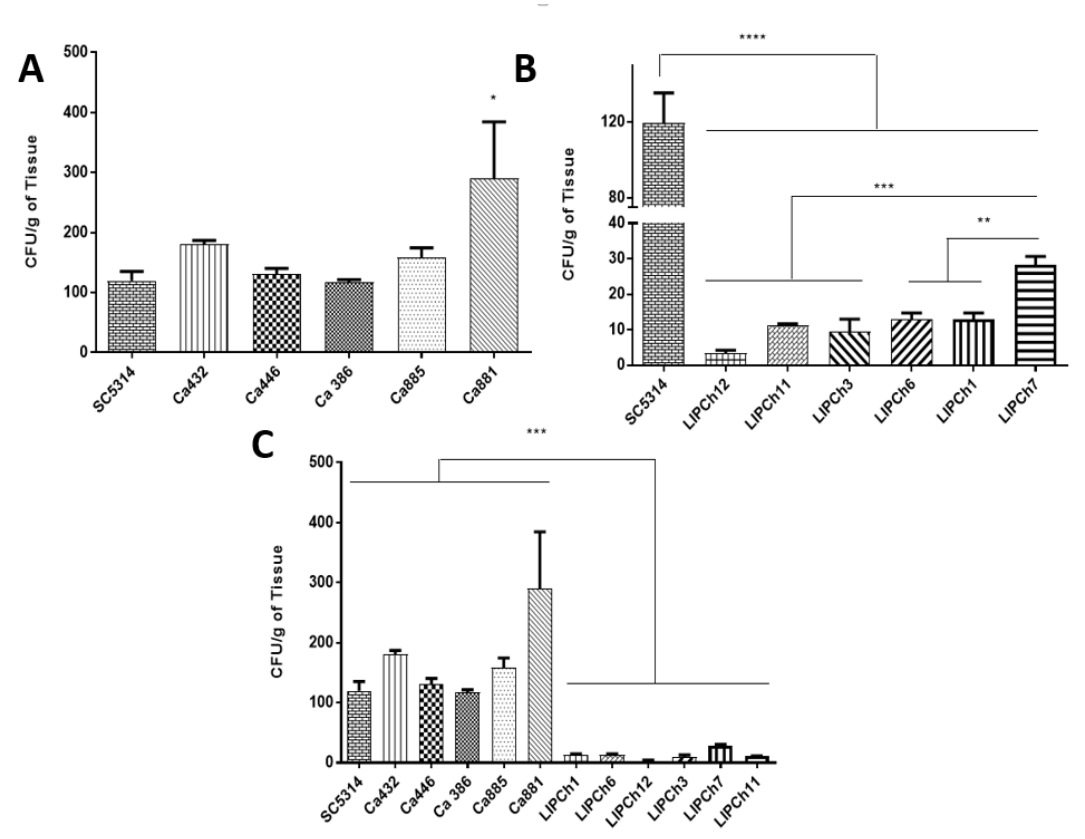
Figure 2. Galleria mellonella larvae were infected with 5 × 10 4 yeasts of C. auris (Ca432; Ca446; Ca386; Ca885; Ca881) or C. haemulonii complex (LIPCh1; LIPCh6; LIPCh12; LIPCh3; LIPCh7; LIPCh11) and sacrificed 3 h or 3 days after infection, respectively. The colony forming units (CFUs) were quantified after 24 h of growth in Sabouraud agar plates. ( A ) CFU of larvae infected with different strains of C. auris. ( B ) CFU of larvae infected with different strains of C. haemulonii complex. ( C ) Comparison among all species tested. As positive control C. albicans SC5314 was used. Data are representative of three independent experiments. * p < 0.05, ** p < 0.001 and *** p < 0.0001. Error bars represent standard deviations between samples (biologic replicates) from the same group.